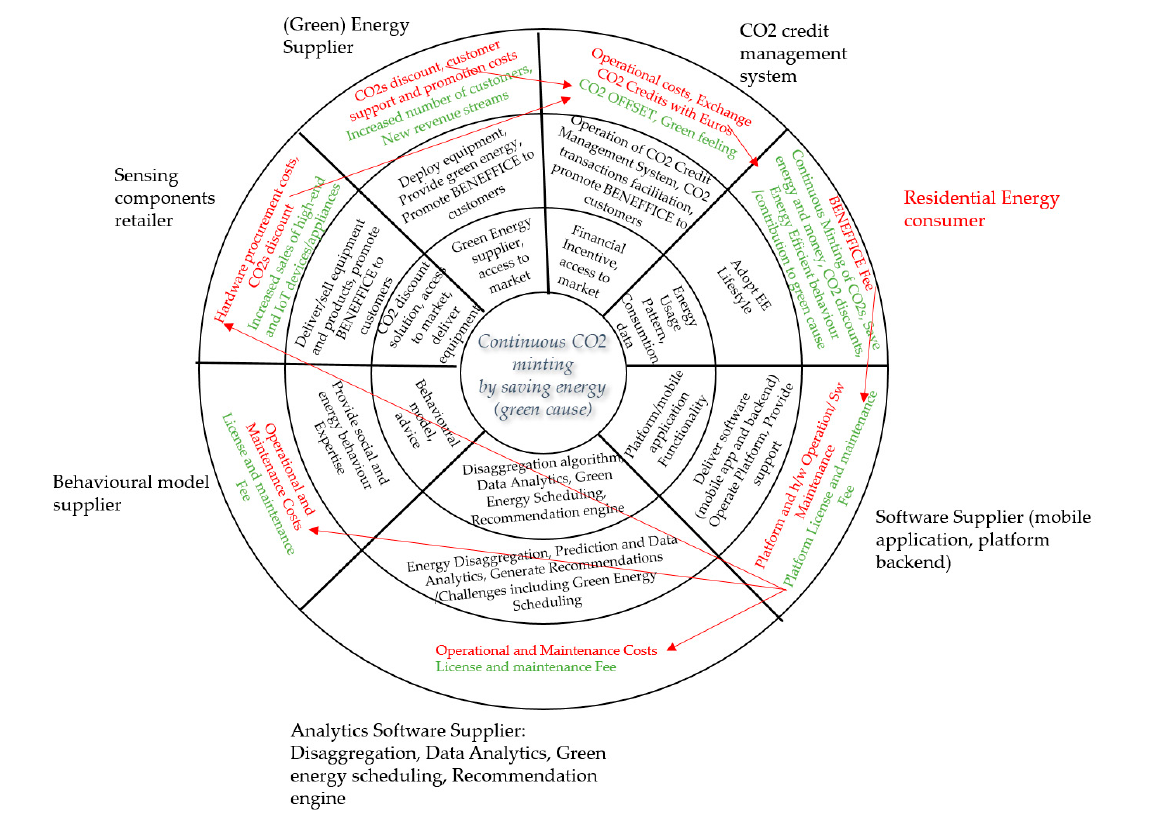
Figure 2. BENEFFICE business model radar. Table 1. BENEFFICE service (Centre of the Radar).